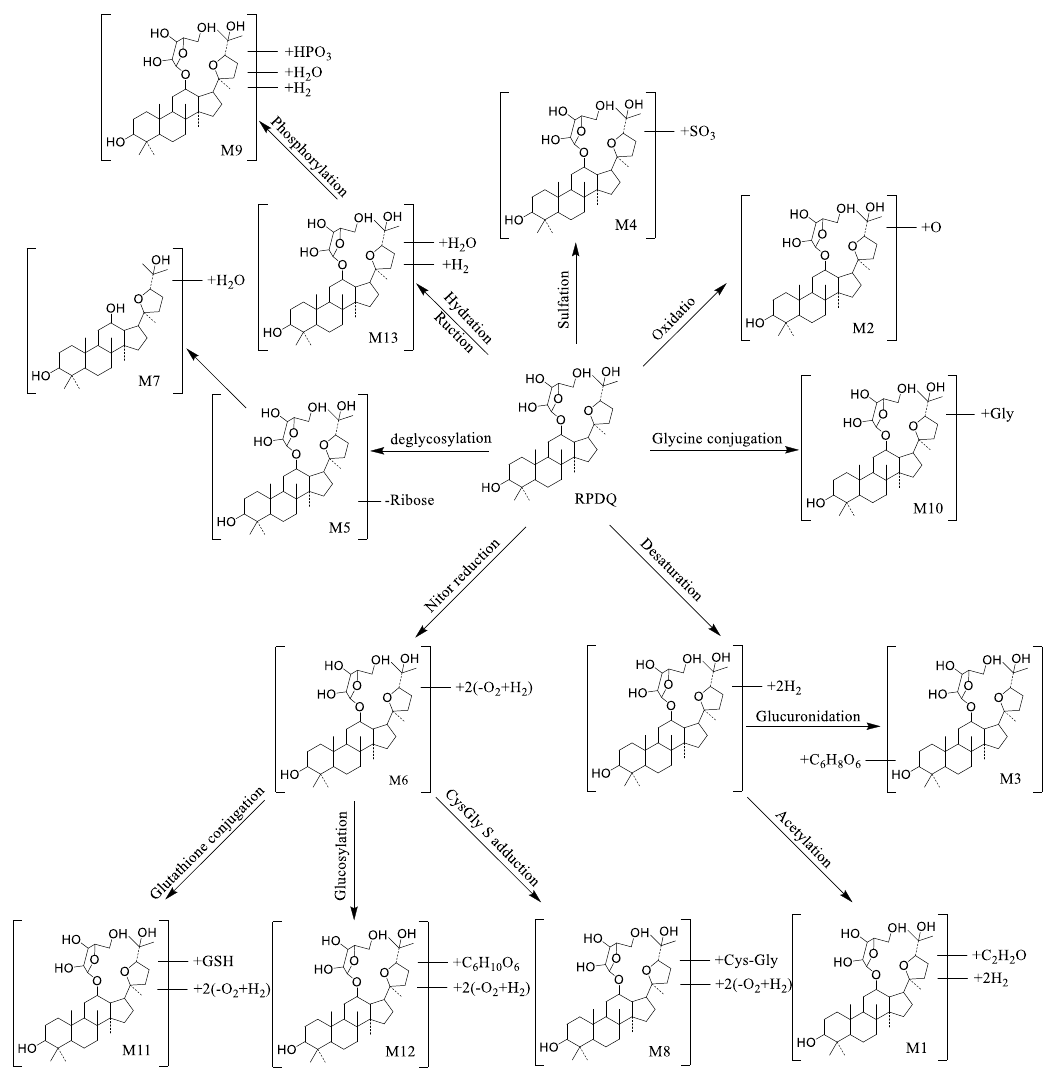
Figure 4. The proposed metabolic pathways of RPDQ in rats.